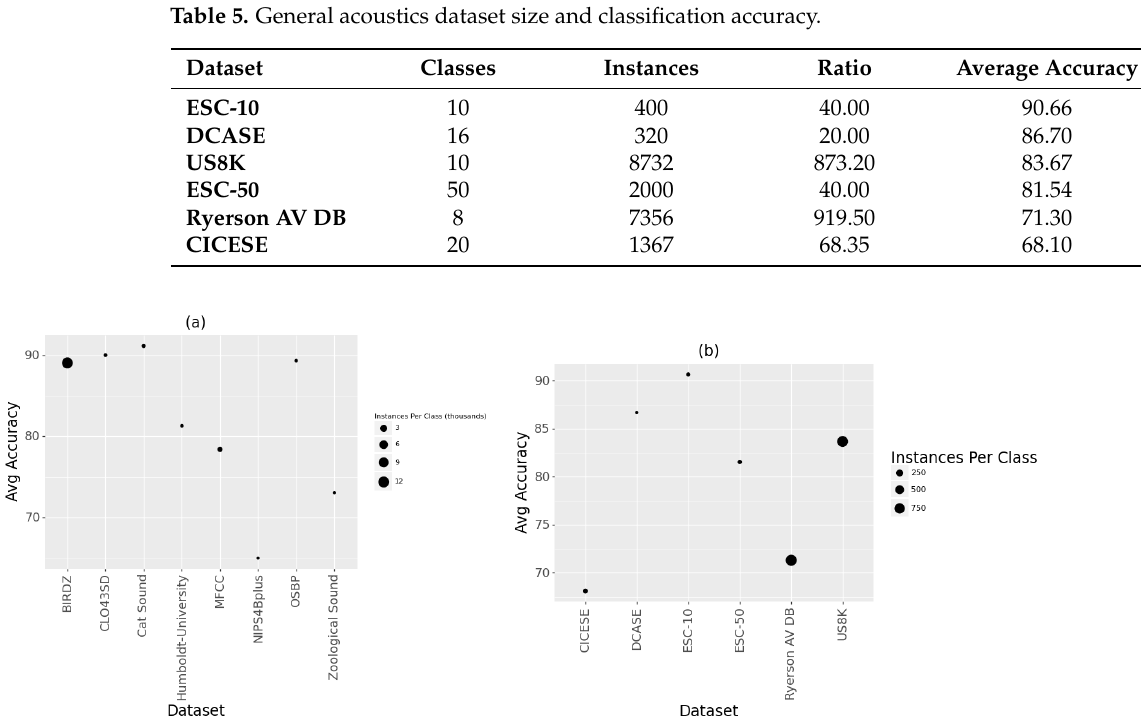
Figure 9. Impact of dataset size on classification accuracy for ( a ) bioacoustics and ( b ) general acoustics